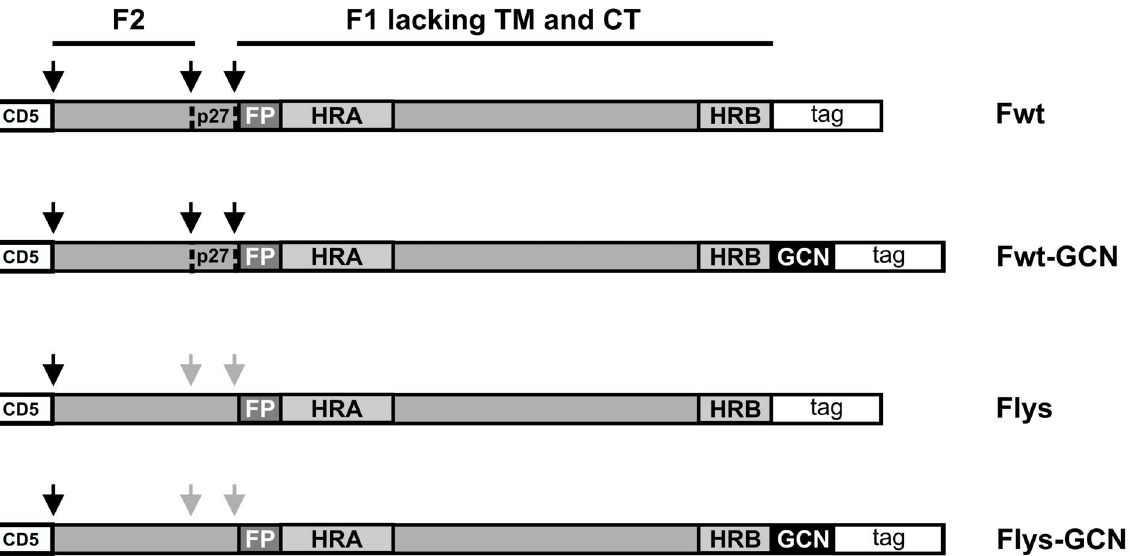
Figure 1. Schematic representation of the different recombinant soluble RSV F protein constructs. RSV F proteins lacking the transmembrane domain (TM) and cytoplasmic tail (CT) were genetically fused to a CD5 signal peptide (CD5) and to a carboxy-terminal tag (tag). When indicated a GCN4 trimerization motif (GCN) was introduced between the F protein and the tag. The tag either consisted of a triple Strep-tagII, a LysM peptidoglycan binding domain, or of a combination of the two (Fig. S1). The F2 and F1 subunits of F are indicated, as well as the p27 peptide (P27) that is released after furin cleavage. Protease cleavage sites are indicated by black arrows. Grey arrows indicate mutated furin cleavage sites. The approximate location of the fusion peptide (FP), heptad repeat A (HRA) and B (HRB) is also shown.